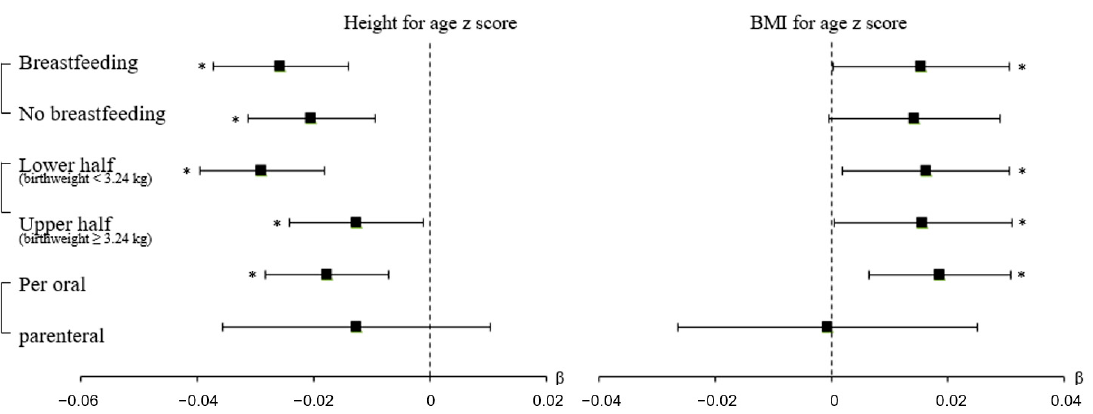
Figure 4. The effect of antibiotic use on HFA z score and BMI for age z score in different subgroups of the main cohort (forest plot) defined by breastfeeding status, birth weight, and route of antibiotic administration. Black filled rectangles indicate β , black lines indicate 95% CIs, and asterisks indicate p < 0.05.